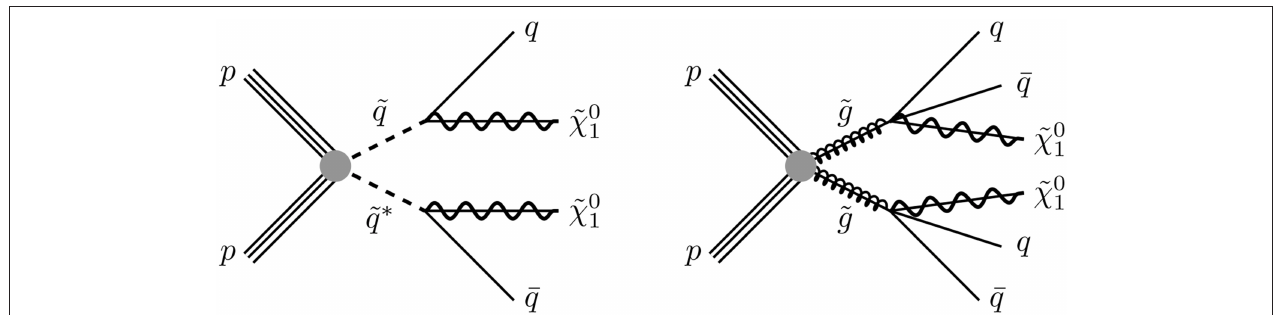
FIGURE 10 | Most simple topologies for the production of squarks and gluinos at the LHC with decays to jets